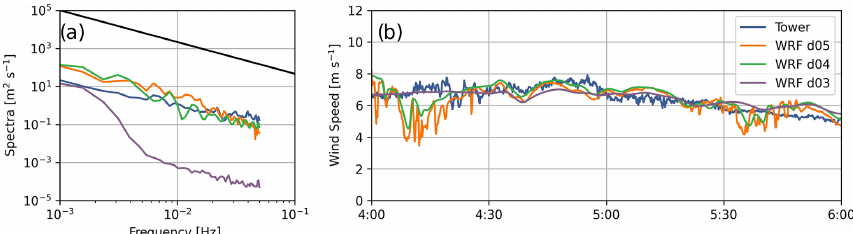
Figure A3. Comparison of (a) time series and (b) spectra between SW_TSE04 tower data and WRF–LES–GAD d05 ( (cid:49)x = 10m), d04 ( (cid:49)x = 50m), and d03 ( (cid:49)x = 150m) for 80m wind speed at SW_TSE04 for the stable case study. The − 5 / 3 inertial subrange power law is provided in black for reference. Note that the model wind speed is output at 10s intervals; therefore, the highest resolvable frequency with this time series is 0.05Hz.